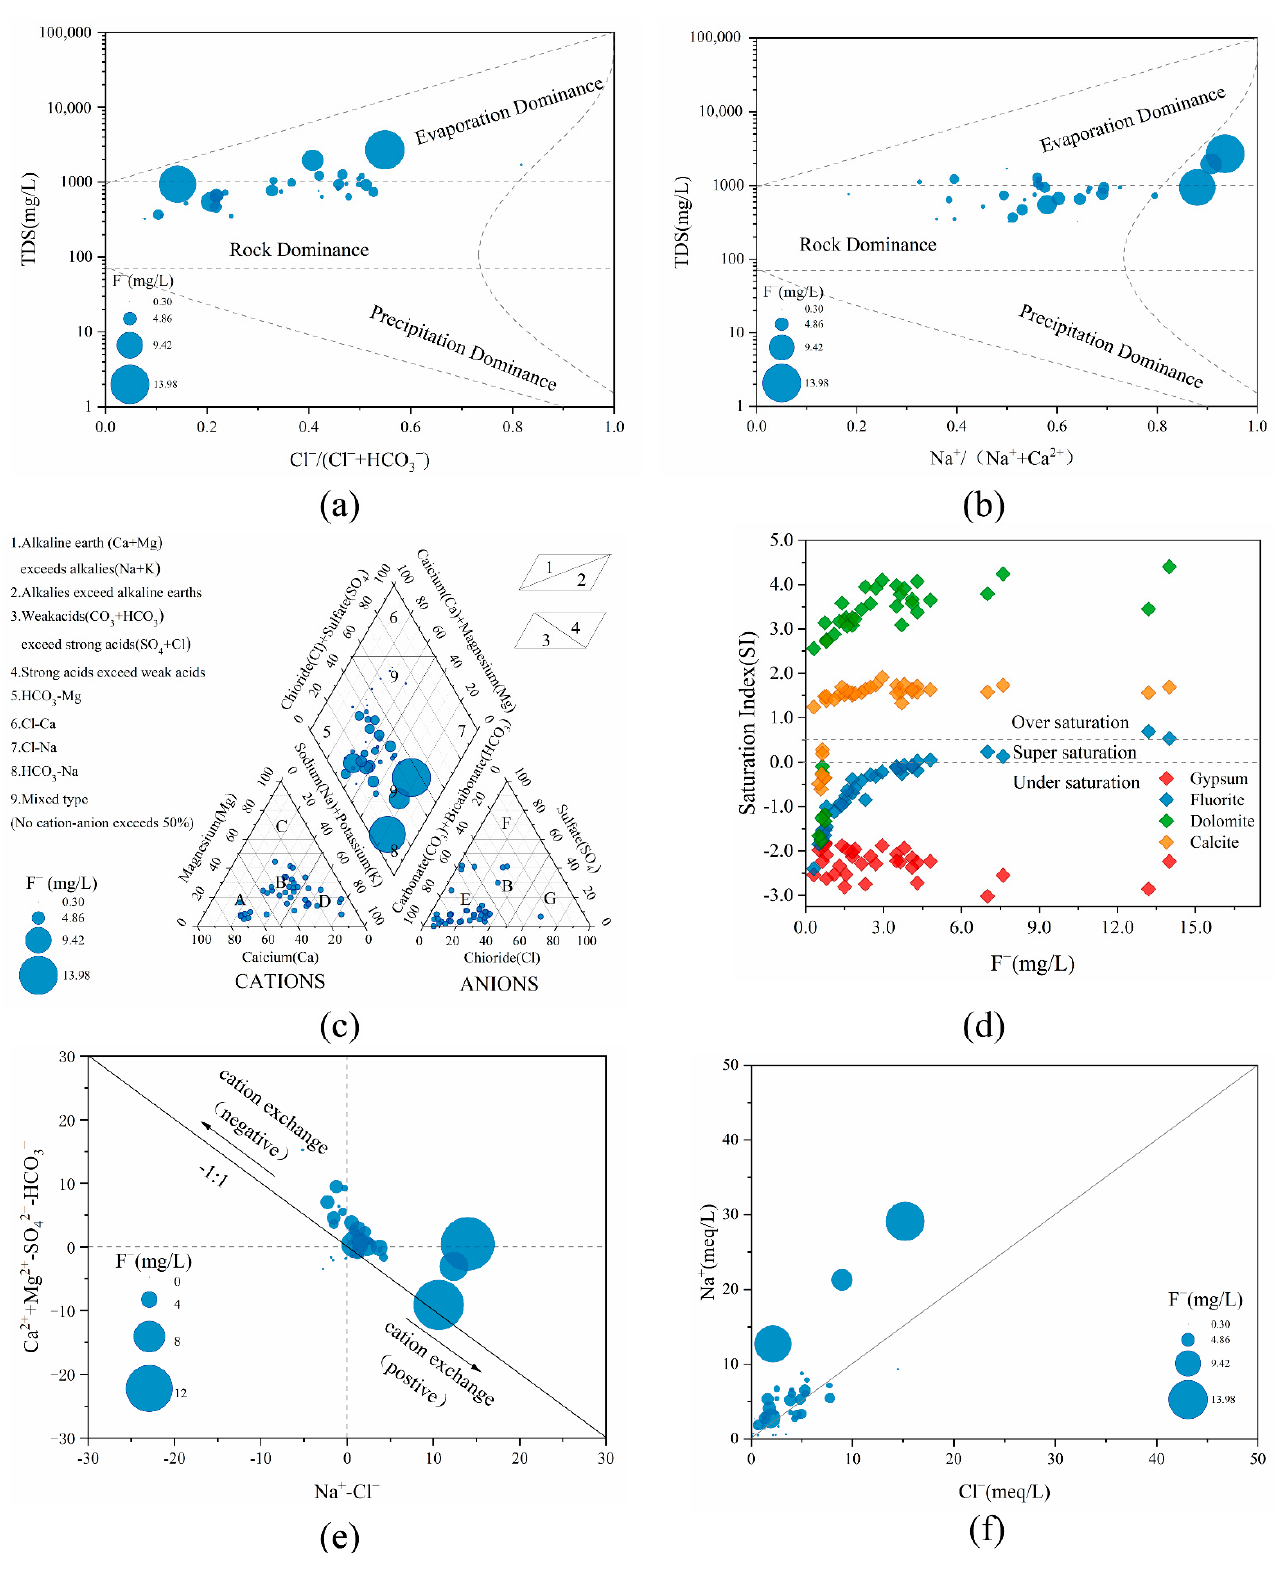
Figure 5. ( a ) TDS vs. Na + /(Na + +Ca 2+ ); ( b ) TDS vs. Cl − /(Cl − +HCO 3 − ); ( c ) Piper plot; ( d ) saturation index (SI) vs. F − ; ( e ) Ca 2+ +Mg 2+ -HCO 3 − -SO 4 2 − vs. Na + -Cl − ; ( f ) Na + vs. Cl −